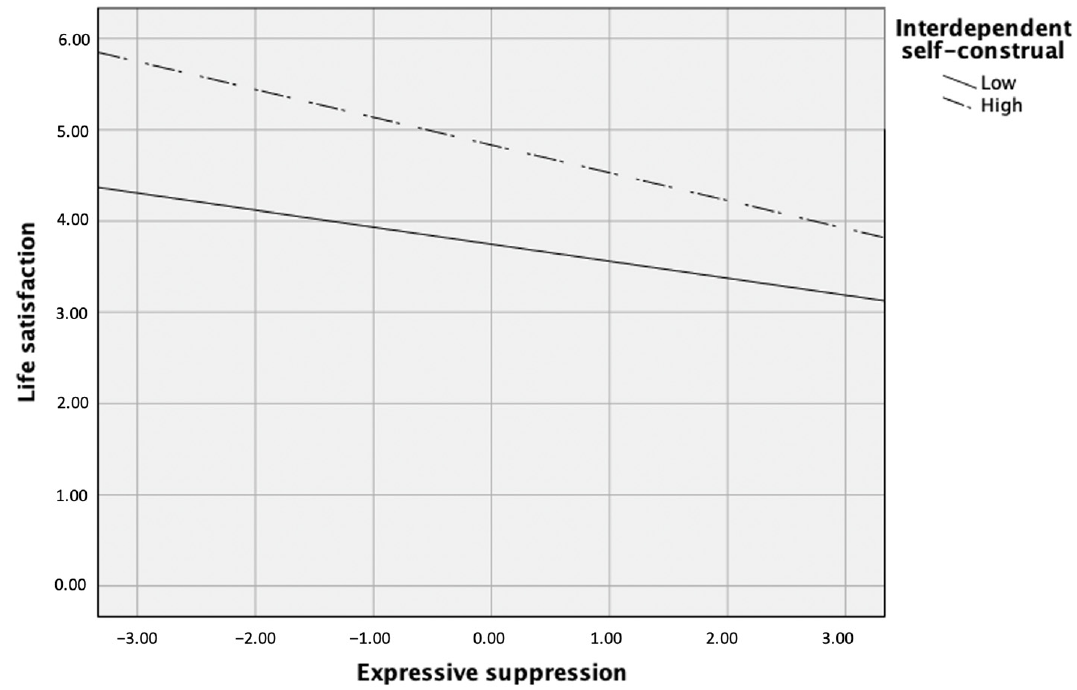
Figure 4. Interdependent self-construal as a moderator between expressive suppression and life satisfaction. Finally, depressive symptoms was predicted by mindfulness ( β = − 0.35, p < 0.001), cognitive reappraisal ( β = − 0.20, p < 0.01), expressive suppression ( β = 0.29, p < 0.001), and the interaction between interdependent self-construal and expressive suppression ( β = − 0.19, p = 0.01), but not by interdependent self-construal alone or the interaction between interdependent self-construal and cognitive reappraisal, p s > 0.05. Post hoc